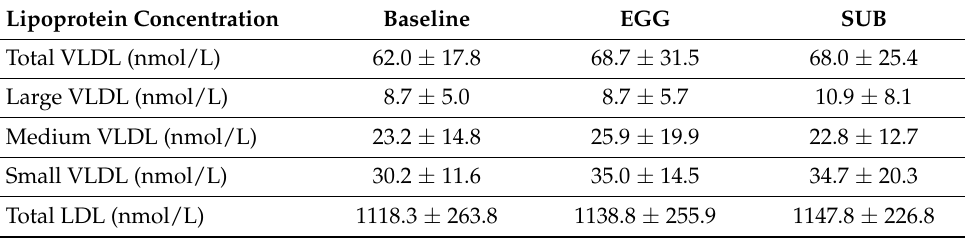
Table 5. Lipoprotein particle concentrations and subfraction analysis from fasting plasma of MetS participants ( n = 24) at baseline and after EGG or SUB diet for 4 weeks each